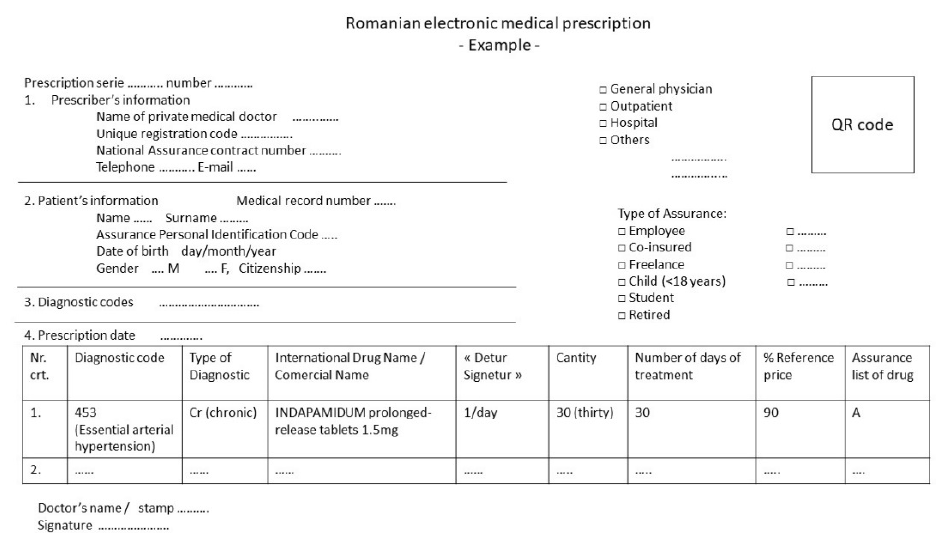
Figure 1. Example of a Romanian electronic medical prescription [31].